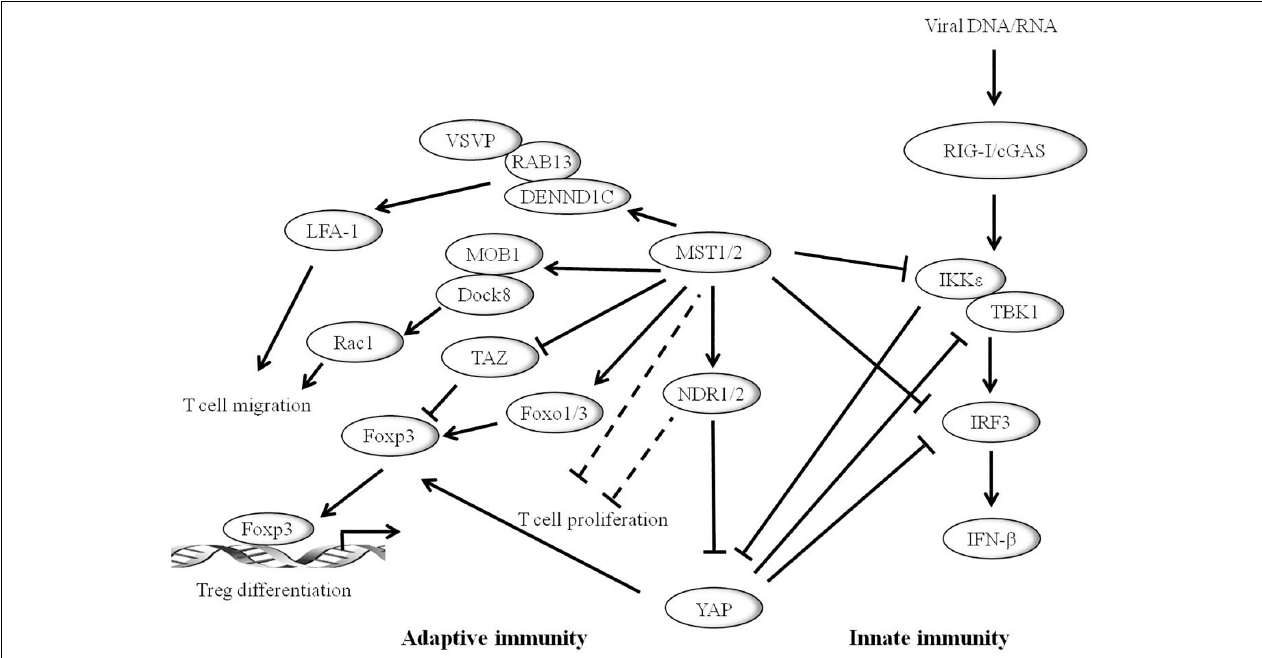
FIGURE 3 | Hippo pathway plays vital role in mammalian immune system. The Hippo core component MST1/2 and YAP can inhibit innate immunity caused by viral infection through the RIG-I/cGAS-TBK1/IKK ε -IRF3 axis. IKK ε promotes the degradation of YAP to activate cellular antiviral responses. Hippo pathway is also involved in adaptive immunity. MST1/2 enhances T cell migration by activating LFA-1 though DENND1C-RAB13 and VASP signaling, or via MST1-MOB1-Dock8-Rac1 axis. MST1/2 promotes regulatory T cell (Treg) differentiation by modulating the Foxp3 expression. YAP promotes the expression of Foxp3, whereas TAZ inhibits its function. Moreover, MST1/2 and/or NDR1/2 may inhibit the development of T cells.